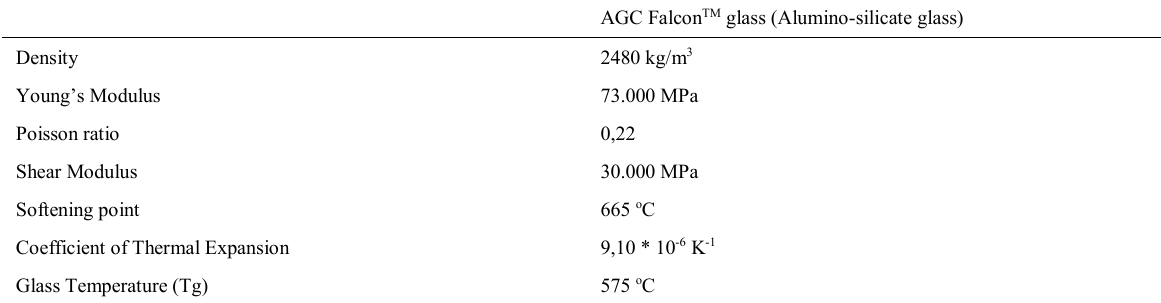
Table 1: Properties of Falcon glass from AGC (AGC, 2017, p.